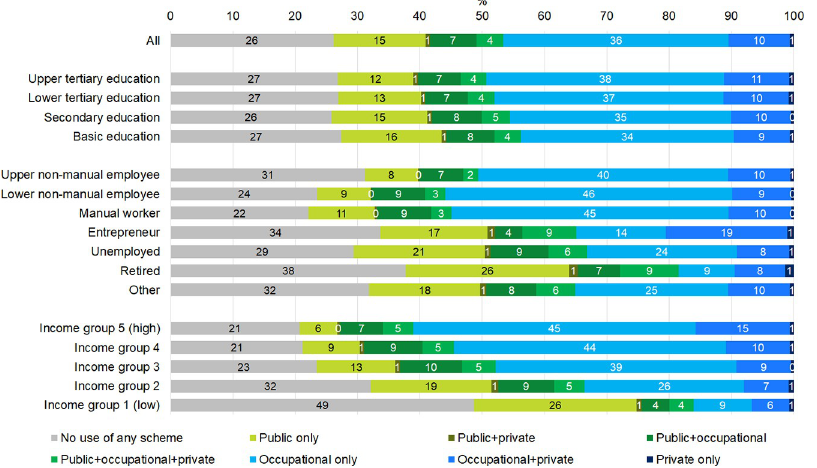
Fig 3. Average adjusted predictions from multinomial logit models of users of primary outpatient health care schemes during year among men 2013 according to socioeconomic variables. Residents of Oulu, Finland, men aged 25–64 in 2013 (N = 47 024).